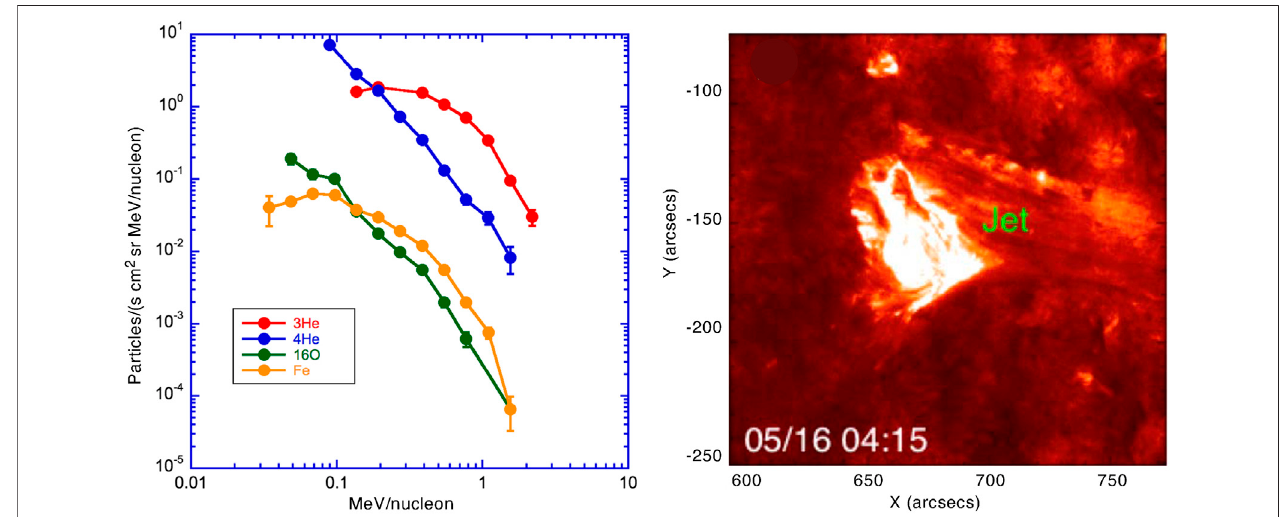
FIGURE1 | The 2014 May 16 ISEP event. Left: AdvancedComposition Explorer (ACE) ULEIS energyspectra for selected ion species.The 3 He and Fe spectra are rounded, the 4 He and O show power law shape. Adapted from Nitta et al. (2015). © AAS. Reproduced with permission. The 3 He/ 4 He ∼ 14.9 over the energy range 0.5 – 2.0 MeV/nucleon is extremely high. The ratio is a factor of ∼ 4 × 10 4 higher than the solar wind value. The Fe/O at 0.385MeV/nucleon is ∼ 2.1. The 28 Si and 32 S had also curved spectra in this event (Mason et al., 2016). Right: SDO AIA 304 Å direct image of the event solar source showing a jet eruption. Adapted from Mason et al. (2016). © AAS. Reproduced with permission. No X-ray fl are was detected in this